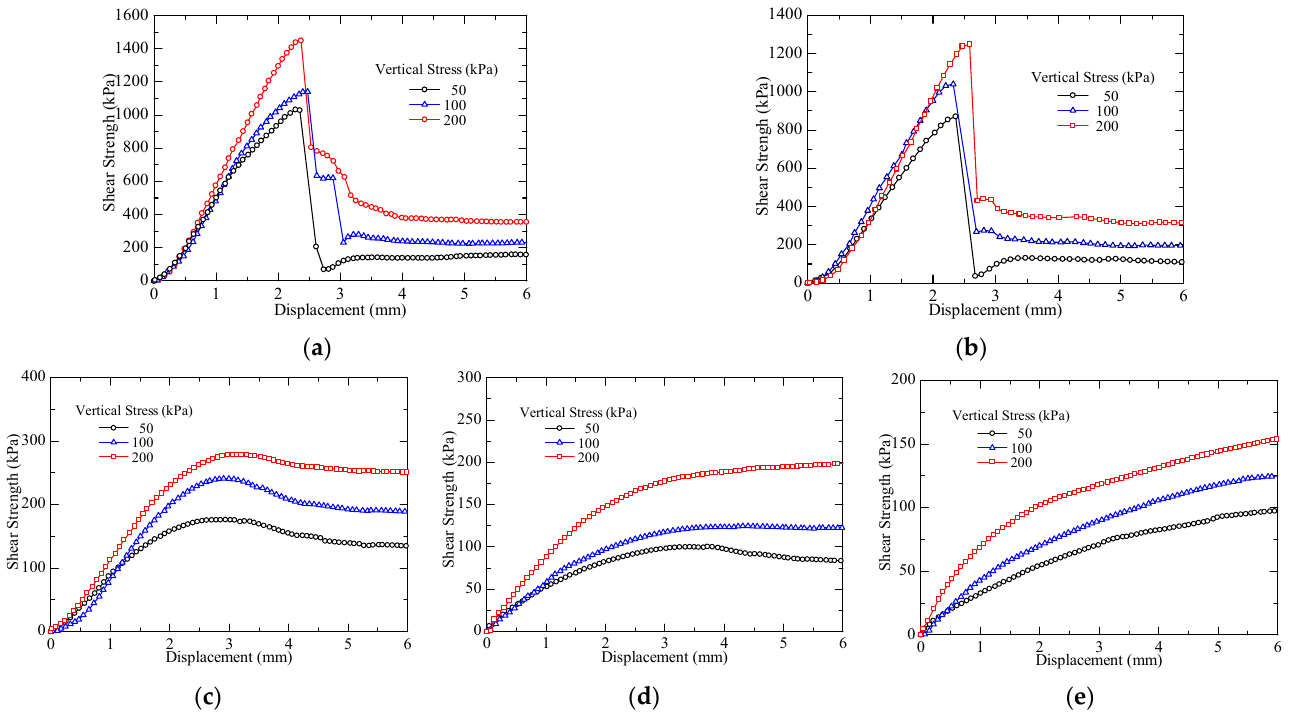
Figure 16. Shear strength of xanthan gum-treated silt with different water contents ( m bp / m s = 2%): ( a ) w = 2%; ( b ) w = 4%; ( c ) w = 8%; ( d ) w = 16%; ( e ) w = 22%.